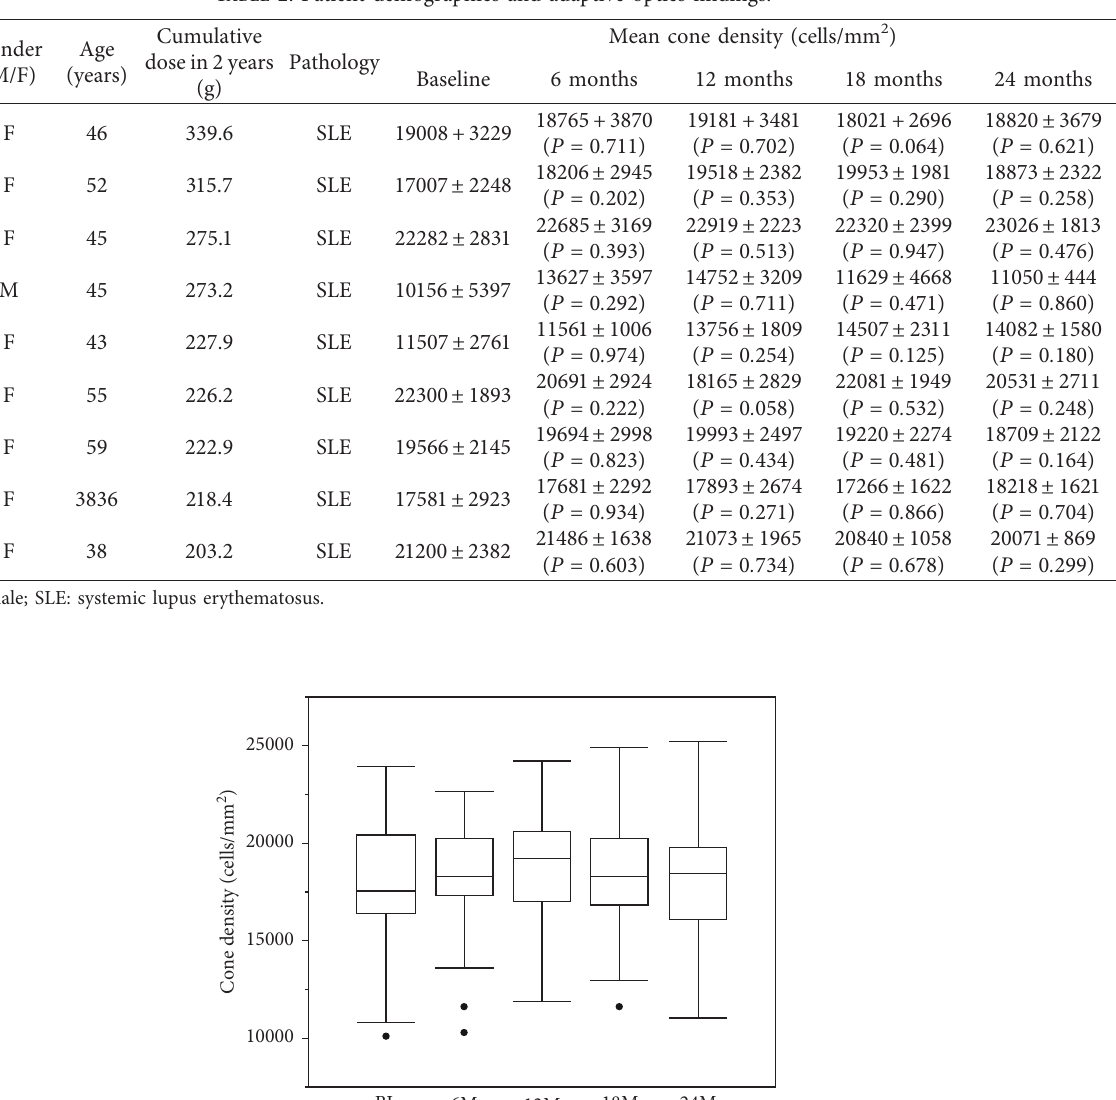
Table 2: Patient demographics and adaptive optics findings.